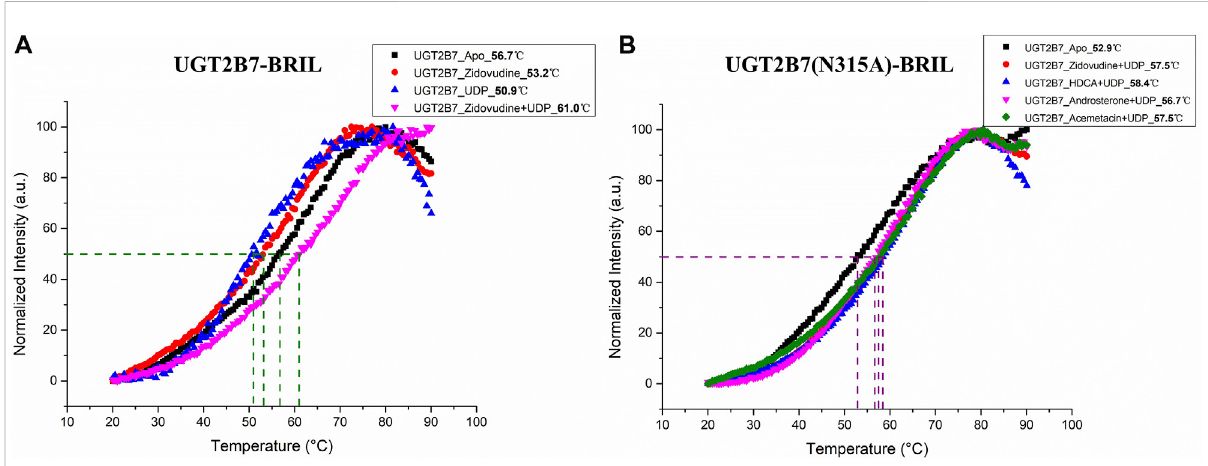
FIGURE 6 Thermostability of UGT2B7-BRIL. (A) the melting temperature (T m ) of UGT2B7-BRIL in the presence of different compounds. (B) the T m of UGT2B7(N315A)-BRIL in the presence of four substrates.